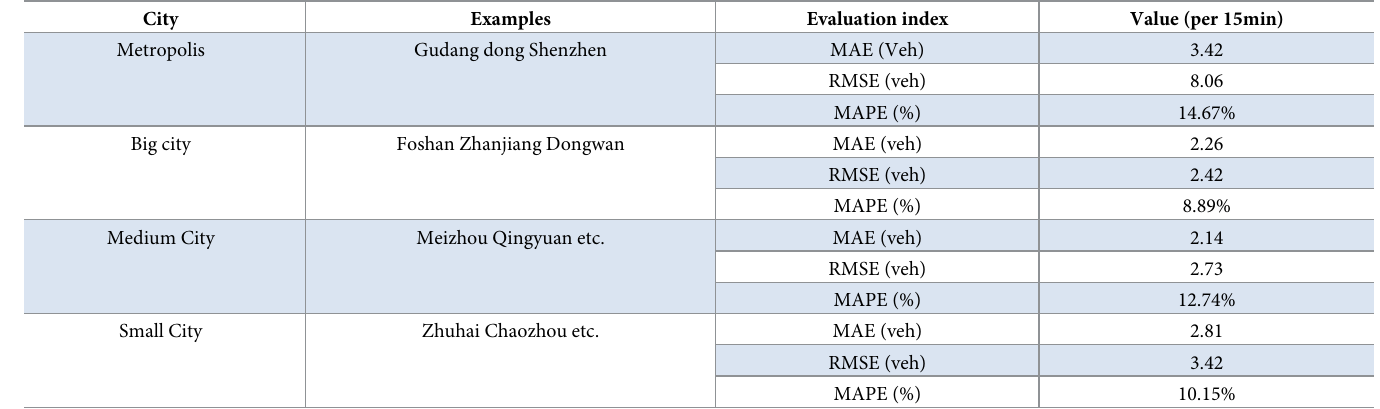
Table 4. Prediction performance for different scale of city toll